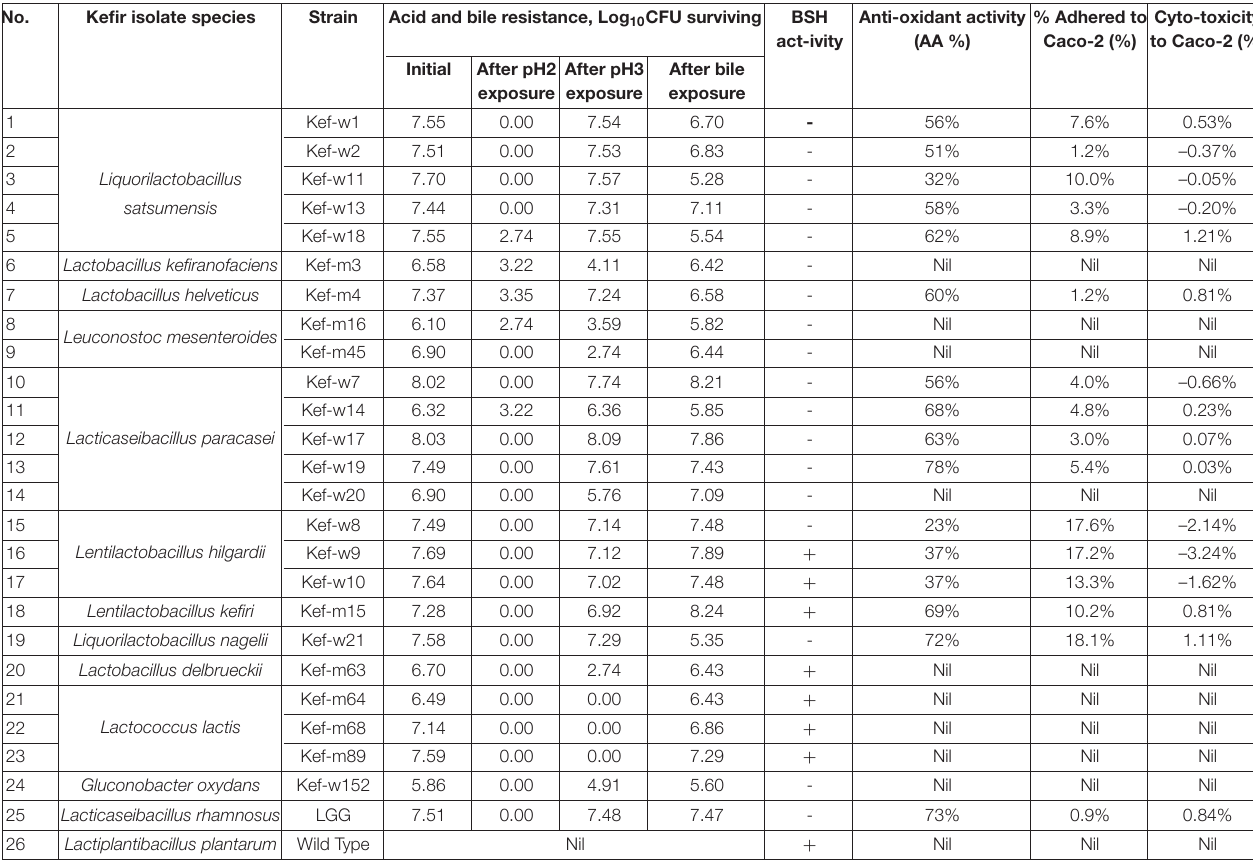
TABLE 5 | Phenotypic properties of selected kefir isolates, including results for acid and bile resistance, bile salt hydrolase (BSH) activity, antioxidant activity, adhesion, and cytotoxicity to Caco-2 cells. a